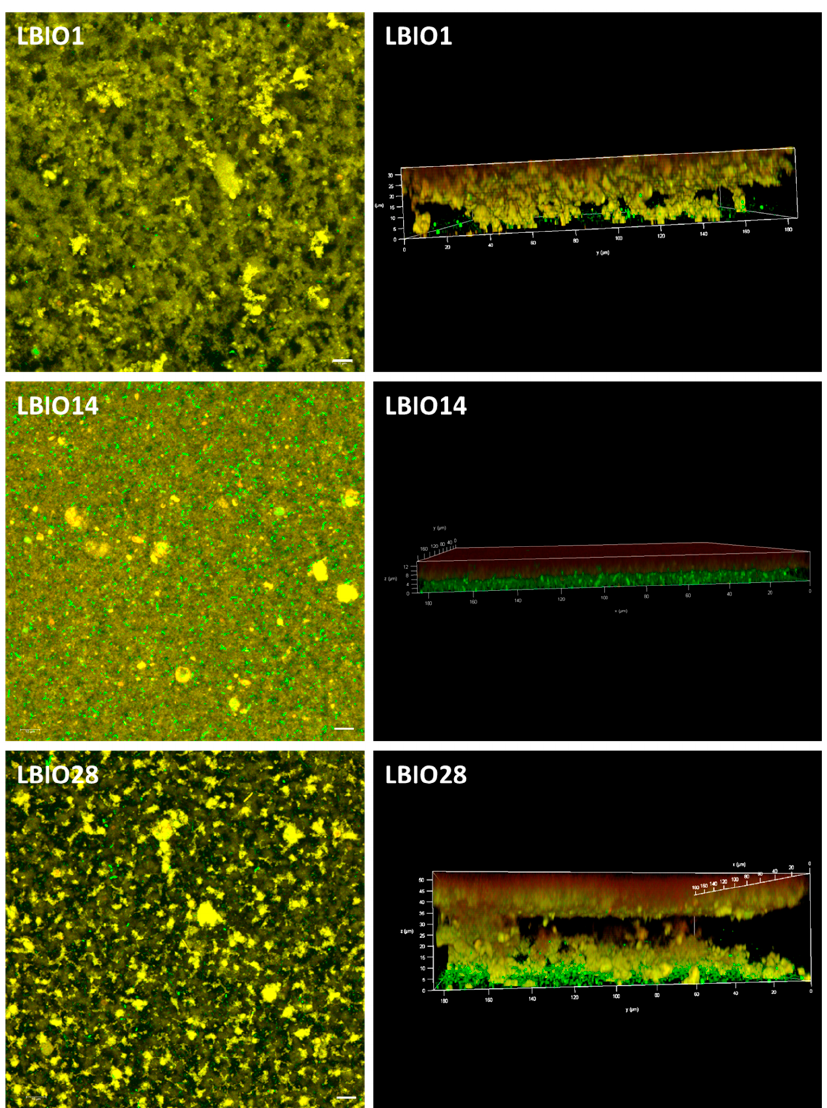
Figure 6. Three-dimensional microstructure of skim-milk gels (casein network stained in yellow) fermented with the EPS-producing strains L. plantarum LBIO1, LBIO14 or LBIO28 (stained in green). Left microphotographs (bar 10 μ m): 3D projection (visualized in XY axes) of several Z-stack images obtained using a 63×/1.40NA oil objective on an inverted Ultra-Spectral Leica TCS AOBS SP2 confocal microscope. Right microphotographs: rotation of the 3D Z-stack images, to see the projection in the three axes (XYZ).